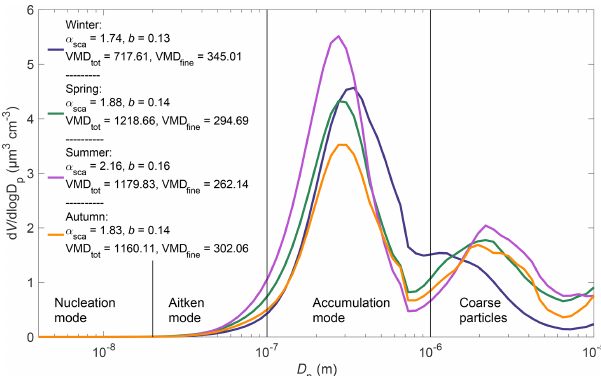
Figure 3. Mean size distribution for winter (December– February), spring (March–May), summer (June–August), and au- tumn (September–November). Also, the average α sca , b , VMD tot , and VMD fine for the seasons are presented in the figure. VMD tot and VMD fine are reported innm.